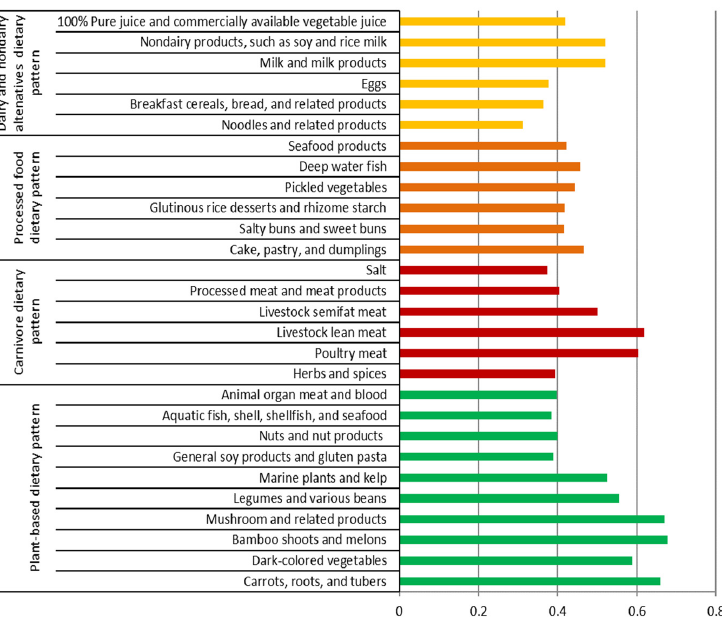
Figure 1. Factor loading of four dietary patterns identified by principal component analysis. The factor loadings of <0.30 were eliminated for simpli fi cation.